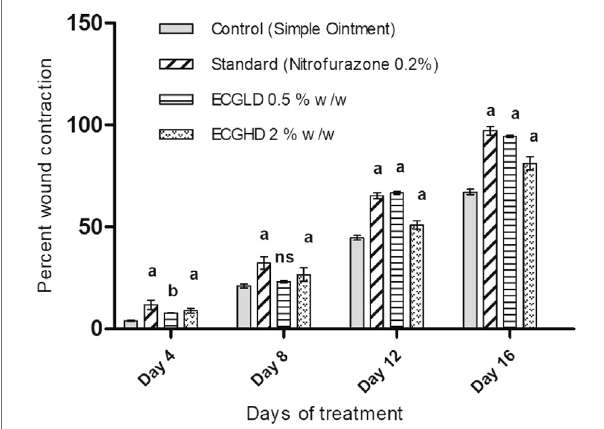
FIGURE 2 | Percentage of wound contraction in excision wound model. ECPLD: extract of C. gigantea (L.) Dryand low dose; ECPHD: extract of C. gigantea (L.) Dryand high dose; a (cid:2) P < 0.001 vs. control; b (cid:2) P < 0.01 vs. control; c (cid:2) p < 0.05 vs.